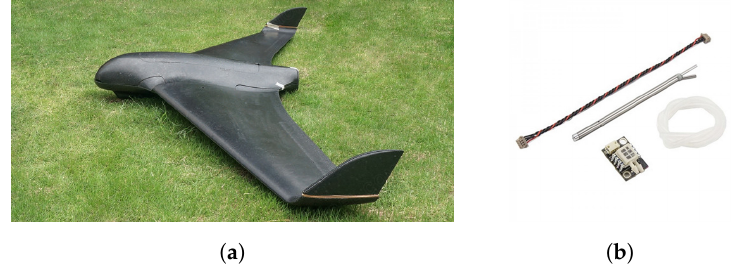
Figure 13. Sensor and UAS platform utilized in experiments. ( a ) UAS SkyWalker X8, (SkyWalker Technology Co., Ltd, Wuhan, China) with carbon fiber frame equipped with a 12 × 6 prop with 2 × 20 g servomotor; ( b ) Digital airspeed sensor utilized in experiments which contains a 4525DO sensor (TE Connectivity Ltd., Schaffhausen, Switzerland) which enables a resolution of 0.84 Pa [33].